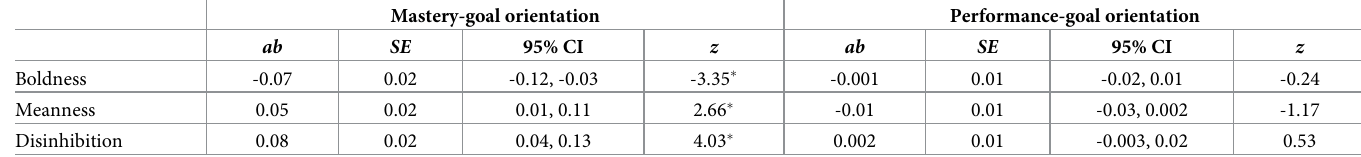
Table 2. Mediation analysis concerning whether achievement goals mediate the relation between psychopathy facets and academic